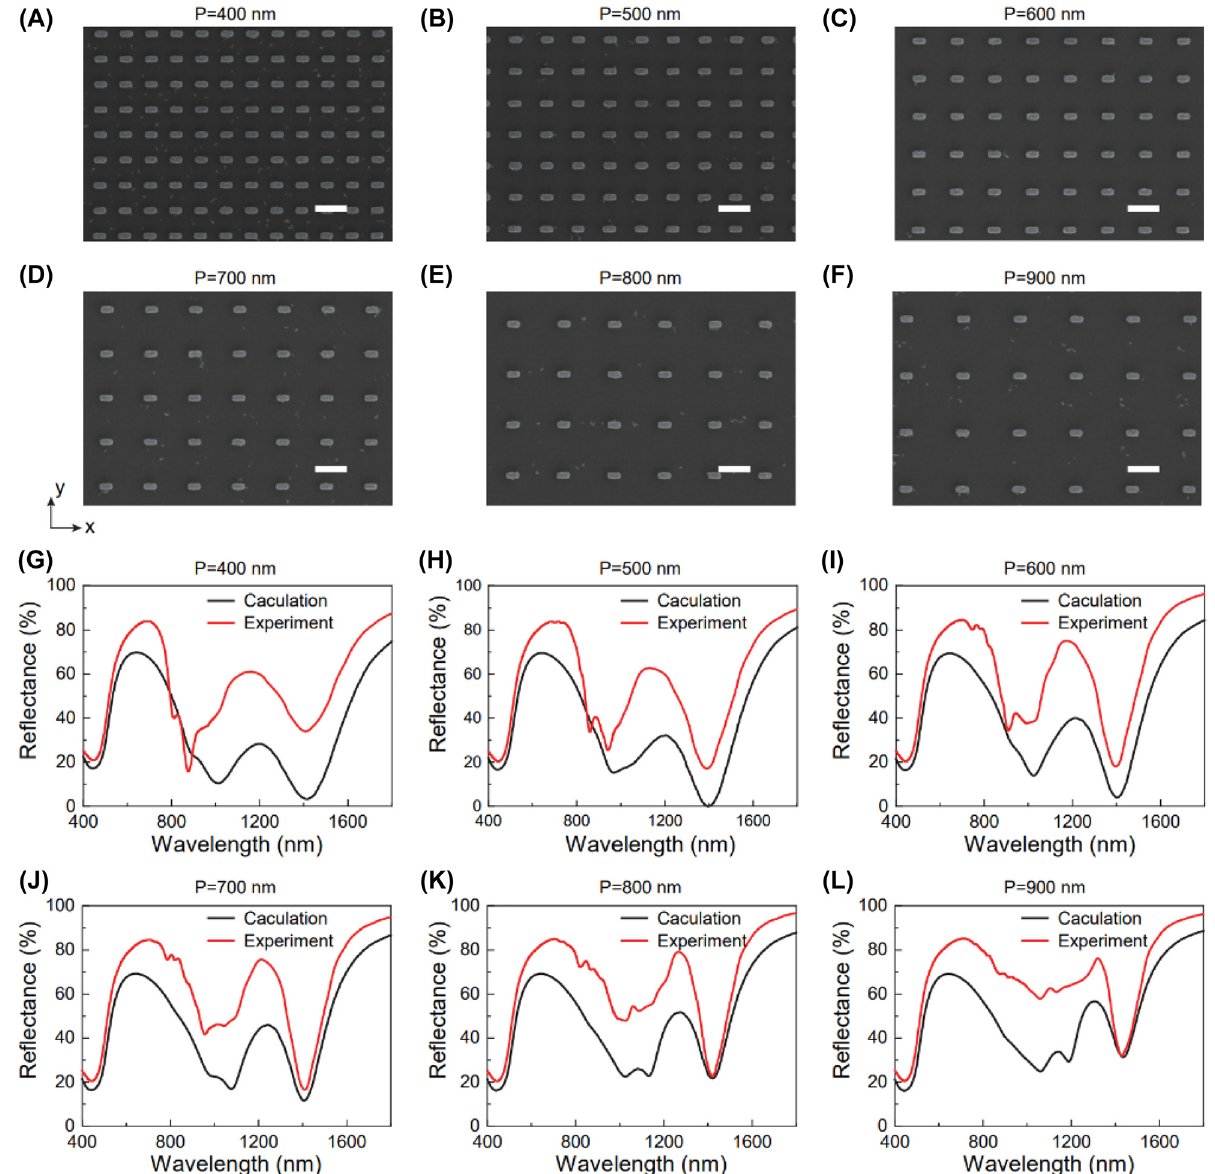
Figure 2: Linear optical properties of the gold/ α -Si hybrid metasurfaces. Scanning electron microscope images of the metasurfaces with varying